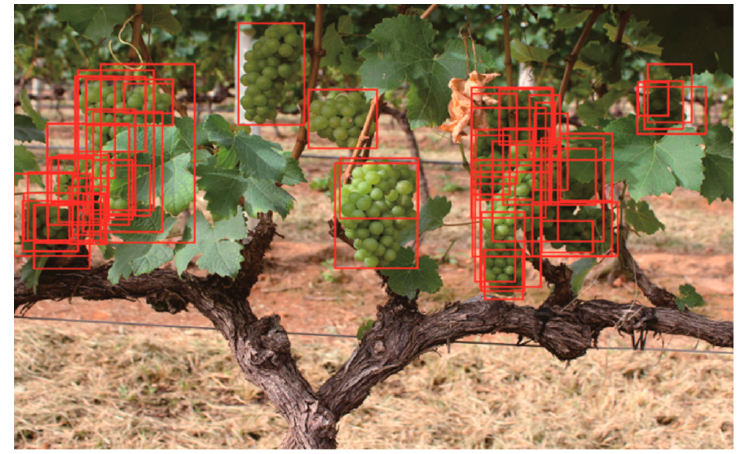
Figure 6. The predicted bounding boxes. To improve the localization accuracy of the optimal bounding boxes, we proposed the R-NMS algorithm, which uses the location information of the bounding boxes around the optimal bounding boxes to perform the repositioning operations on the optimal bounding boxes. The new optimal bounding boxes have better localization accuracy than the former optimal bounding boxes. The Manhattan distance measures the proximity between two bounding boxes: